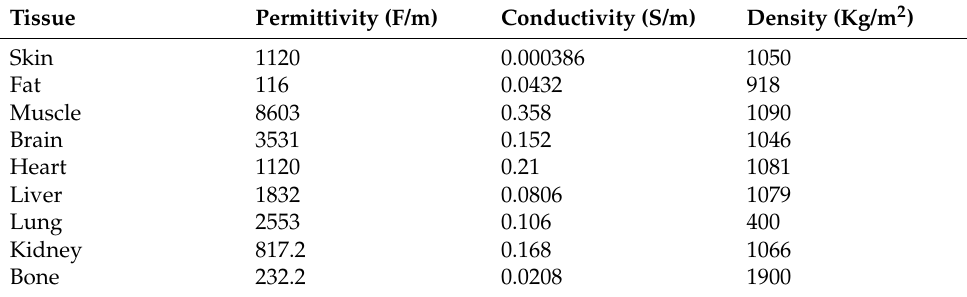
Table 5. Tissue sensitivity values at 85 kHz.